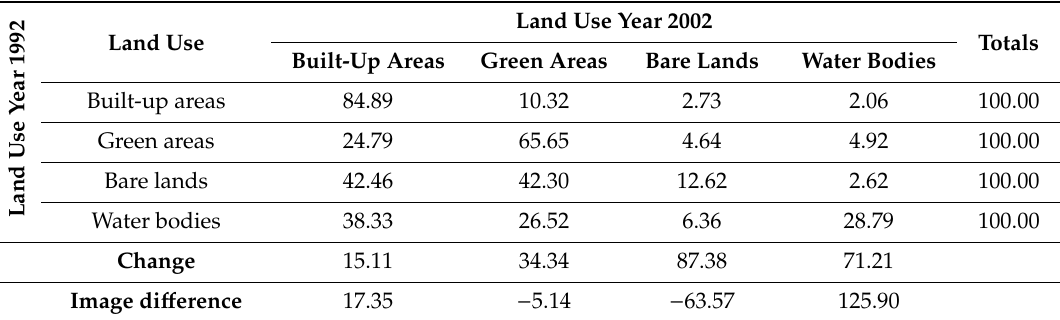
Table 4. Spatial land-use change between 1992 and 2002.